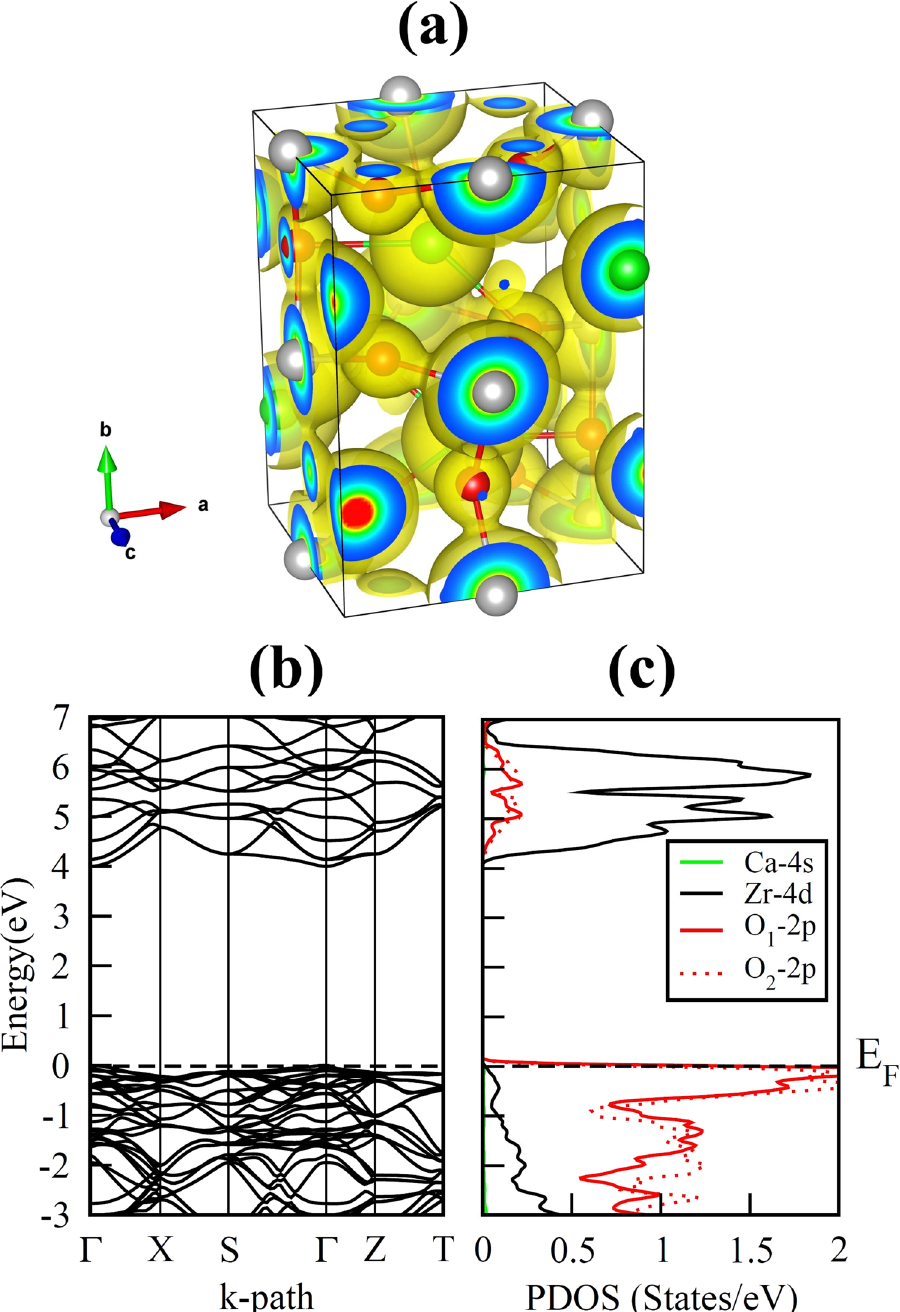
Figure 4. The calculated ( a ) electron-density distribution, ( b ) electronic band structure and ( c ) partial density of states of GGA optimized pristine orthorhombic unit cell of CaZrO 3 . For the electronic-density distribution an isosurface level of 0.3 . . − a u 3 is